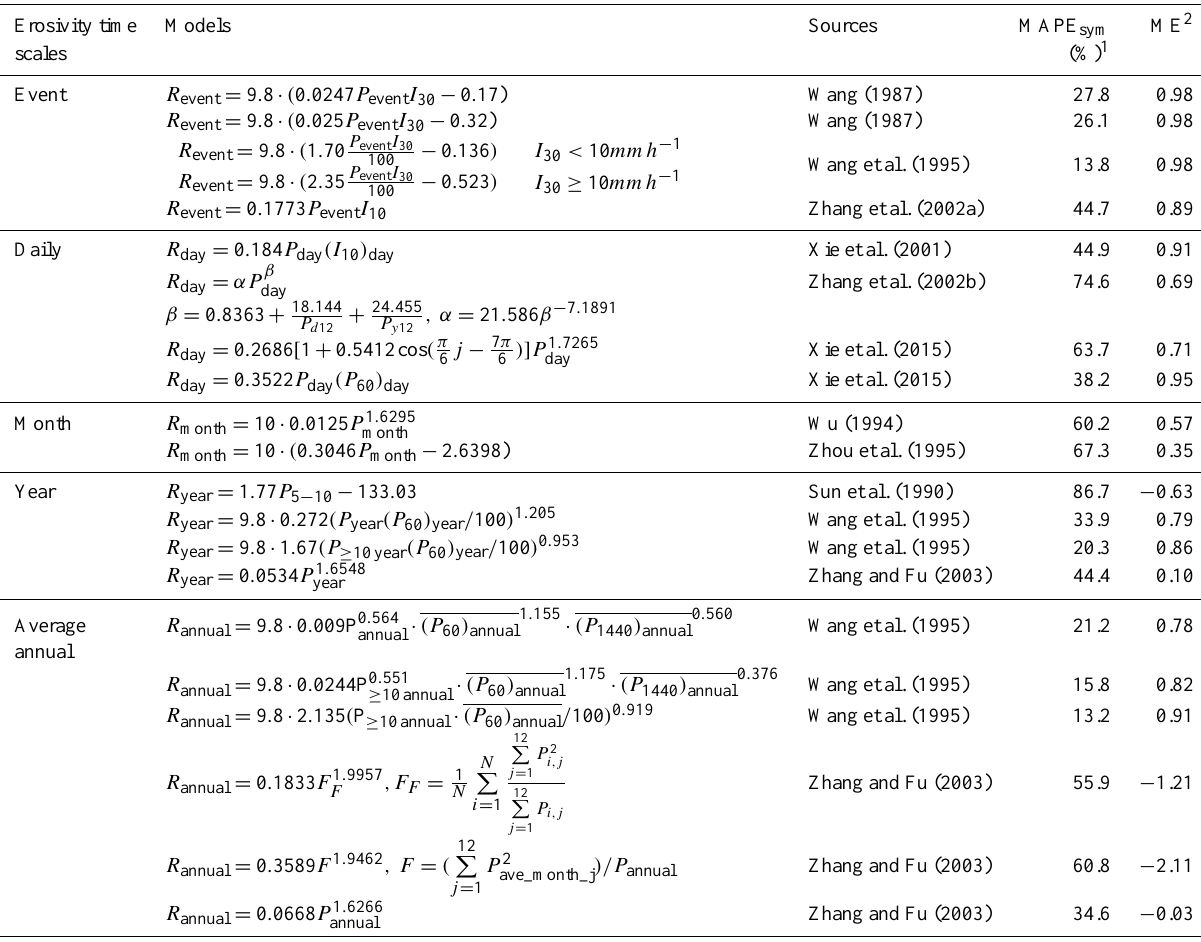
Table 3. Models published in previous research and their prediction capabilities determined using the validation stations – the